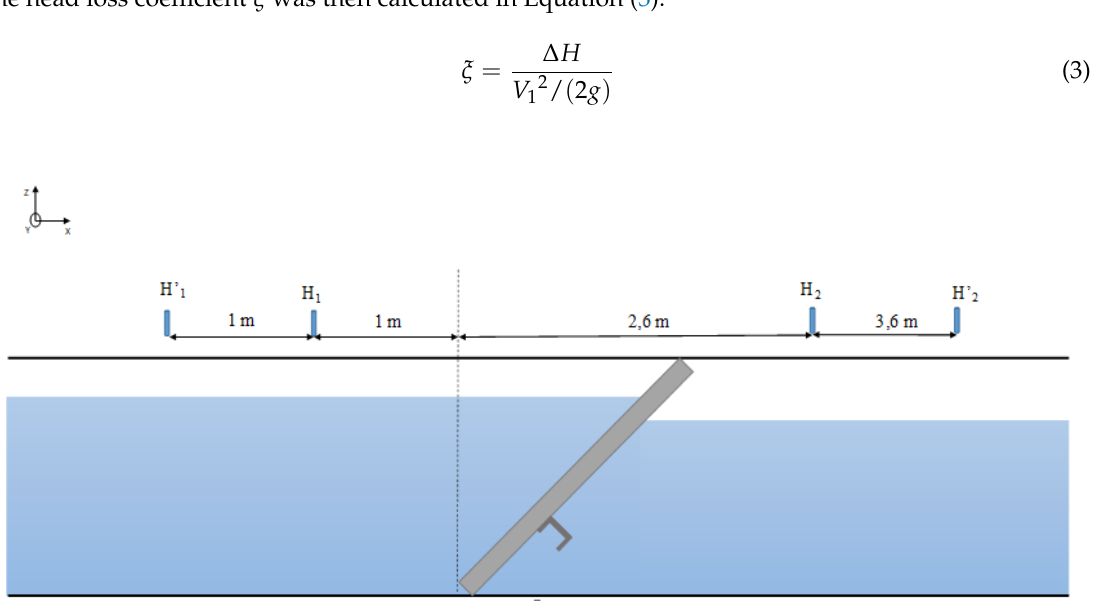
Figure 5. Location of the measurement points in the